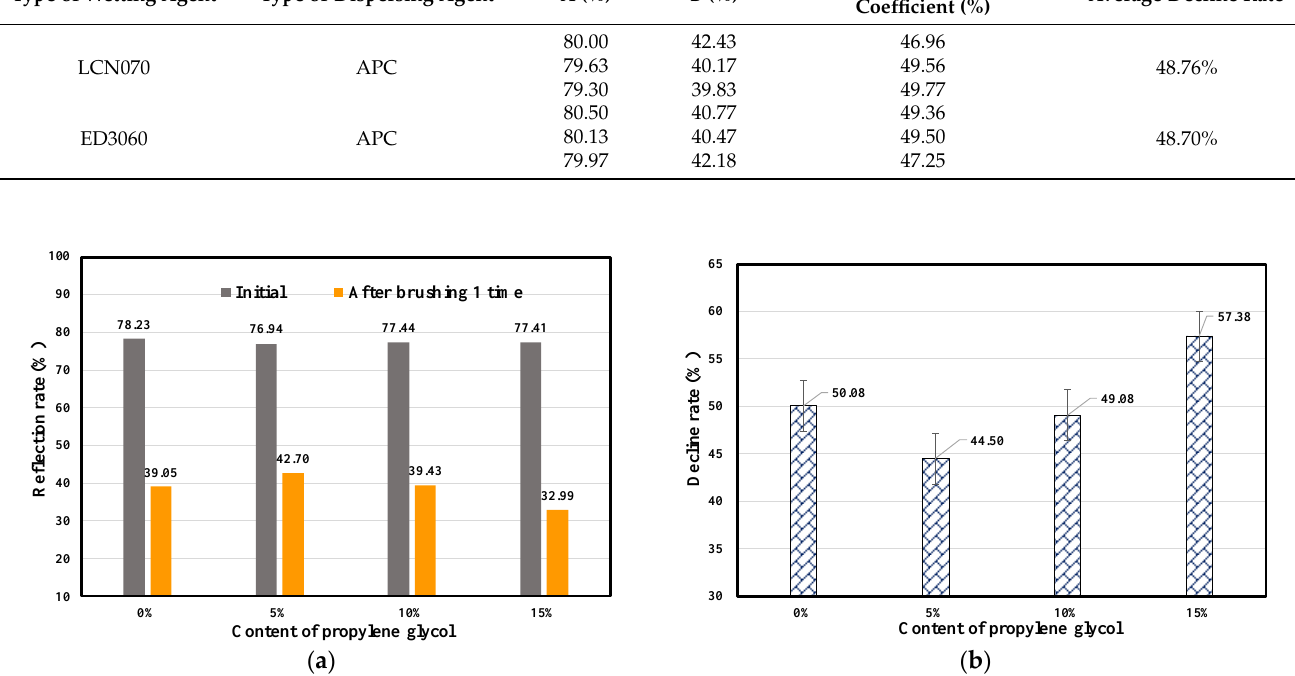
Figure 10. Design 3: ( a ) the change in the reflection rate and ( b ) the decline rate (according to content of propylene glycol).